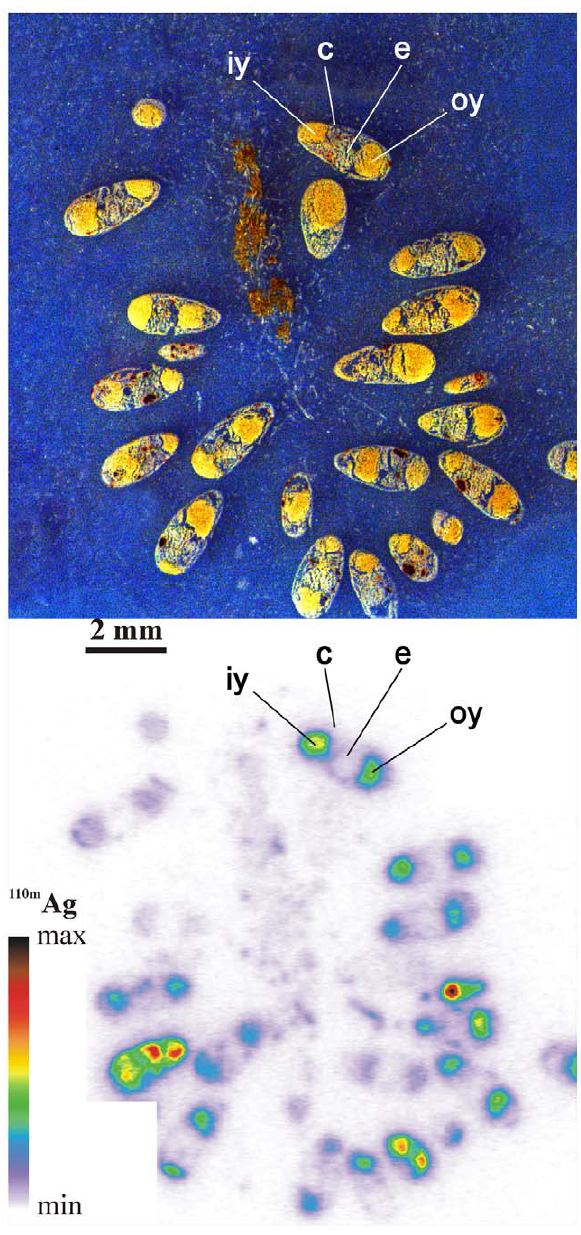
Figure 1. Tissue section (top) and autoradiogram (bottom) of Octopus vulgaris eggs at stage XVI [ 16 ] after exposure to dissolved 110m Ag for 1 week; c: chorion, e: embryo, iy: inner yolk sac, oy: outer yolk